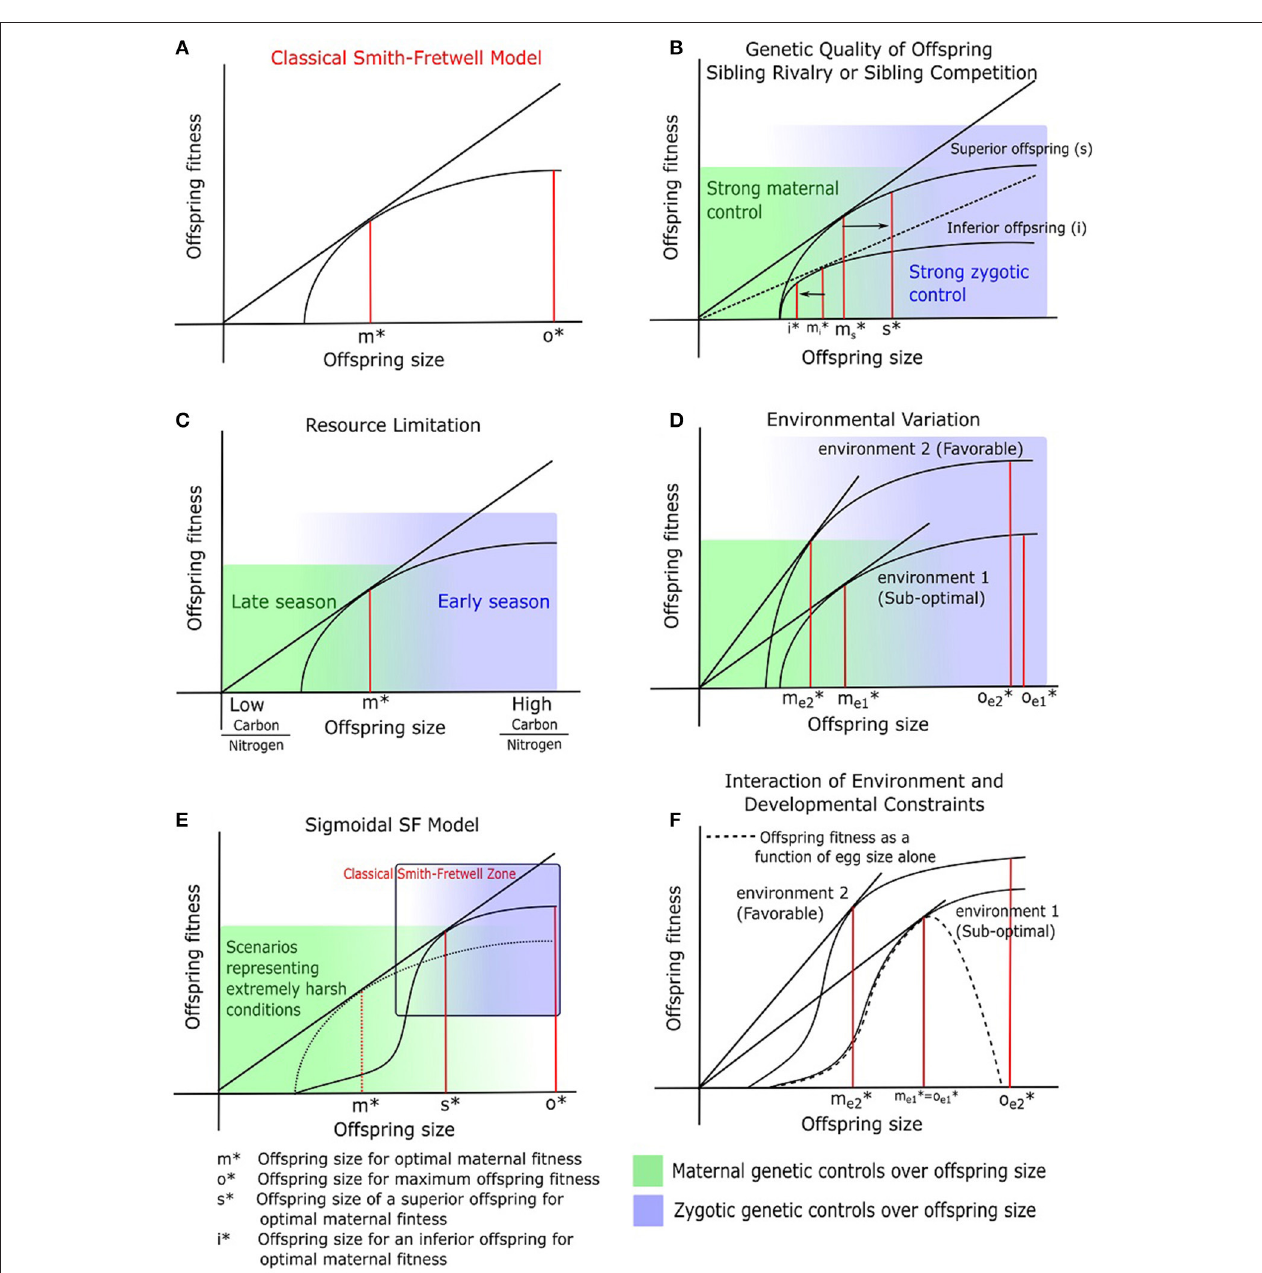
FIGURE 1 | Optimization models tackling offspring size and fitness (A) Classical Smith and Fretwell model (SF model; Smith and Fretwell, 1974), (B) SF model in the context of genetic quality of offspring and sibling rivalry (see Haig, 1990), (C) SF model in the context of resource limitation (adapted from McGinley and Charnov, 1988), (D) Changing slope of the SF curve in response to changing environmental condition (Einum et al., 2004), (E) More accurate sigmoidal representation of the SF model, placed on top of the classical curve (dotted line), and (F) A special case of (D) , where developmental constraints influence offspring fitness (modified from Hendry et al., 2001). The letters symbolize offspring size for maximum fitness corresponding to m*, maternal optimum; o*, offspring optimum; m s * and m i *, original maternal optima for large (genetically superior) and small (inferior) offspring respectively; s*, new maternal optimum for a large offspring with superior genetic make-up; i*, new maternal optimum for the small (inferior) offspring; m e1 * and o e1 *, maternal and offspring optimum in environment 1; m e2 * and o e2 *, maternal and offspring optimum in environment 2. The maternal optimum (s*) deduced from the sigmoidal curve (E) is greater than the expected m* from a conventional SF curve (A) . This greater m* from a sigmoid in (E) is similar to the higher maternal optimum for superior offspring (s*) in (B) . Maternal controls (green shaded gradient) and zygotic controls (blue shaded gradient) on offspring size are indicated in (B–E) , and all are suggesting that it is only when offspring size decreases below m* that maternal controls become strong. However, the nature of maternal-zygotic conflicts near m*, and how it shapes the SF curve remain open questions today.